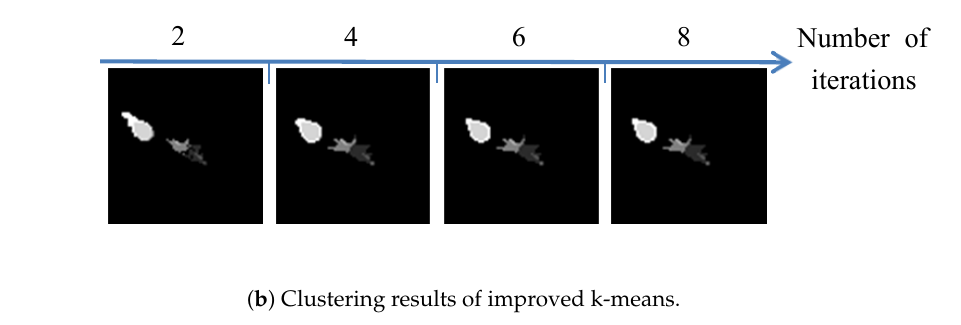
Figure 5. Clustering-result